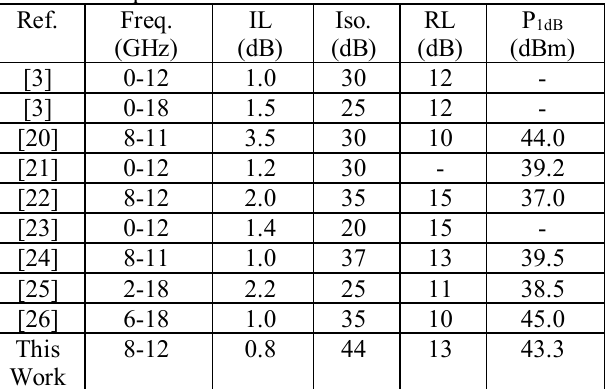
Table 3: Comparison of switch with other state of the